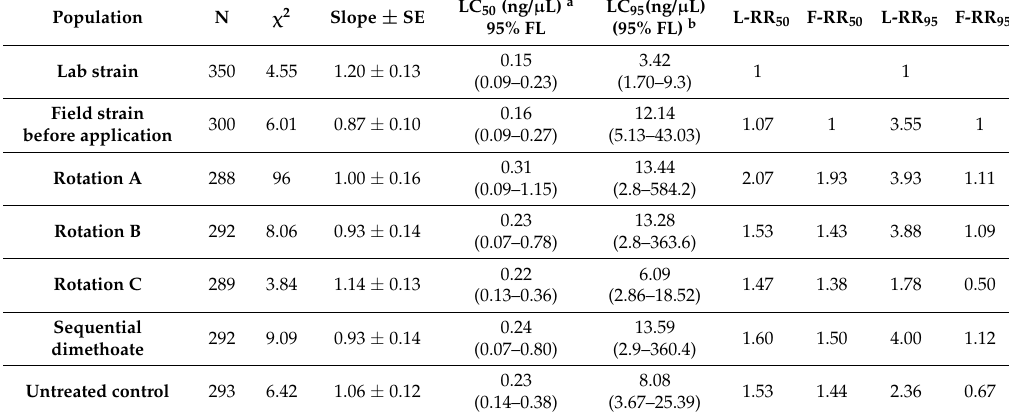
Table 5. Susceptibility of Diaphorina citri adults exposed to fenpropathrin from field plots under different treatment rotations.